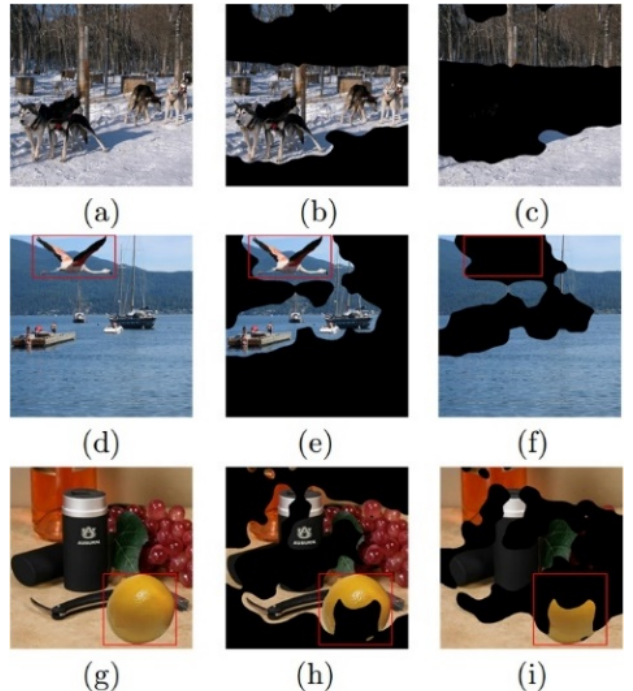
Figure 9. Examples of the CCW salient map results, where ( a – f ) are the images with correct classi- fication, and ( g – i ) are the images with failed classification. ( a ) Untampered image; ( b ) the ROI of the untampered image; ( c ) the RONI of the untampered image; ( d , g ) tampered images; ( e , h ) the ROI of the tampered image; ( f , i ) the RONI of the tampered image.